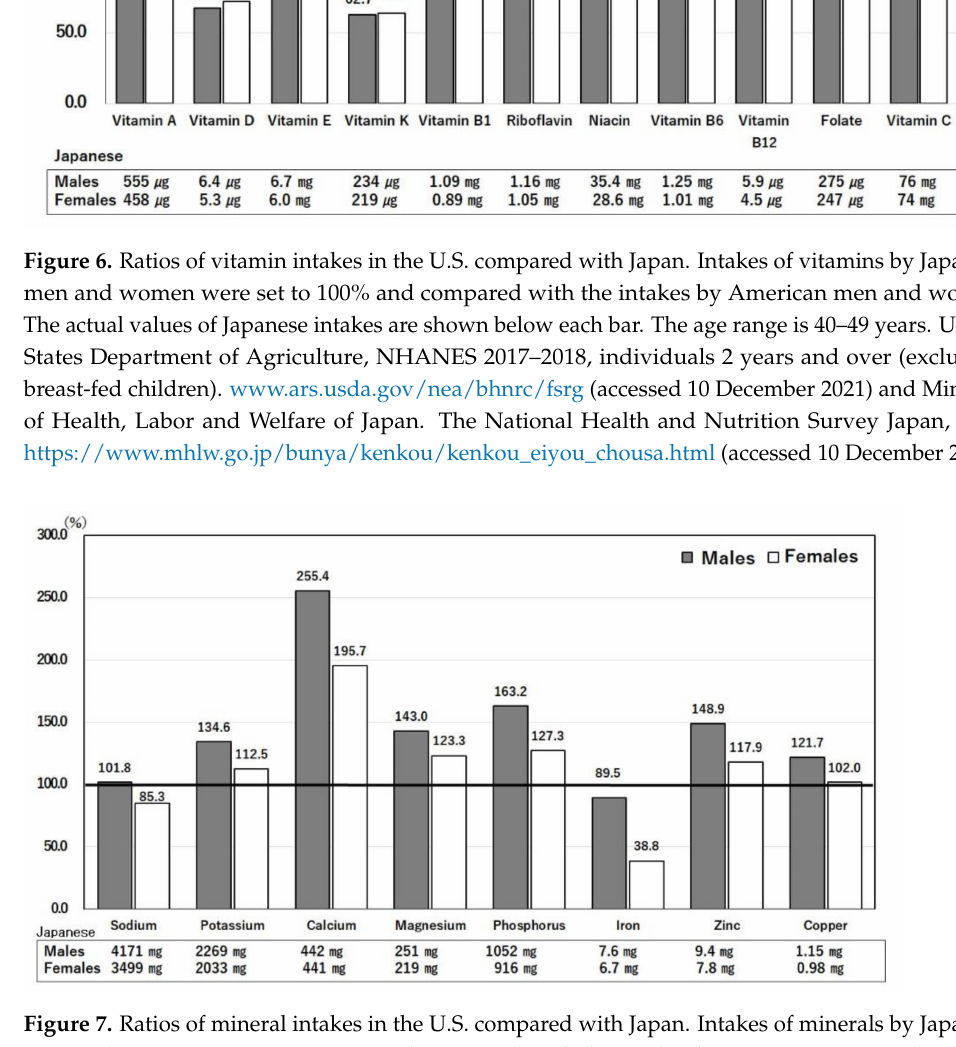
Figure 7. Ratios of mineral intakes in the U.S. compared with Japan. Intakes of minerals by Japanese men and women were set to 100% and compared with the intakes by American men and women. The actual values of Japanese intakes are shown below each bar. The age range is 40–49 years.